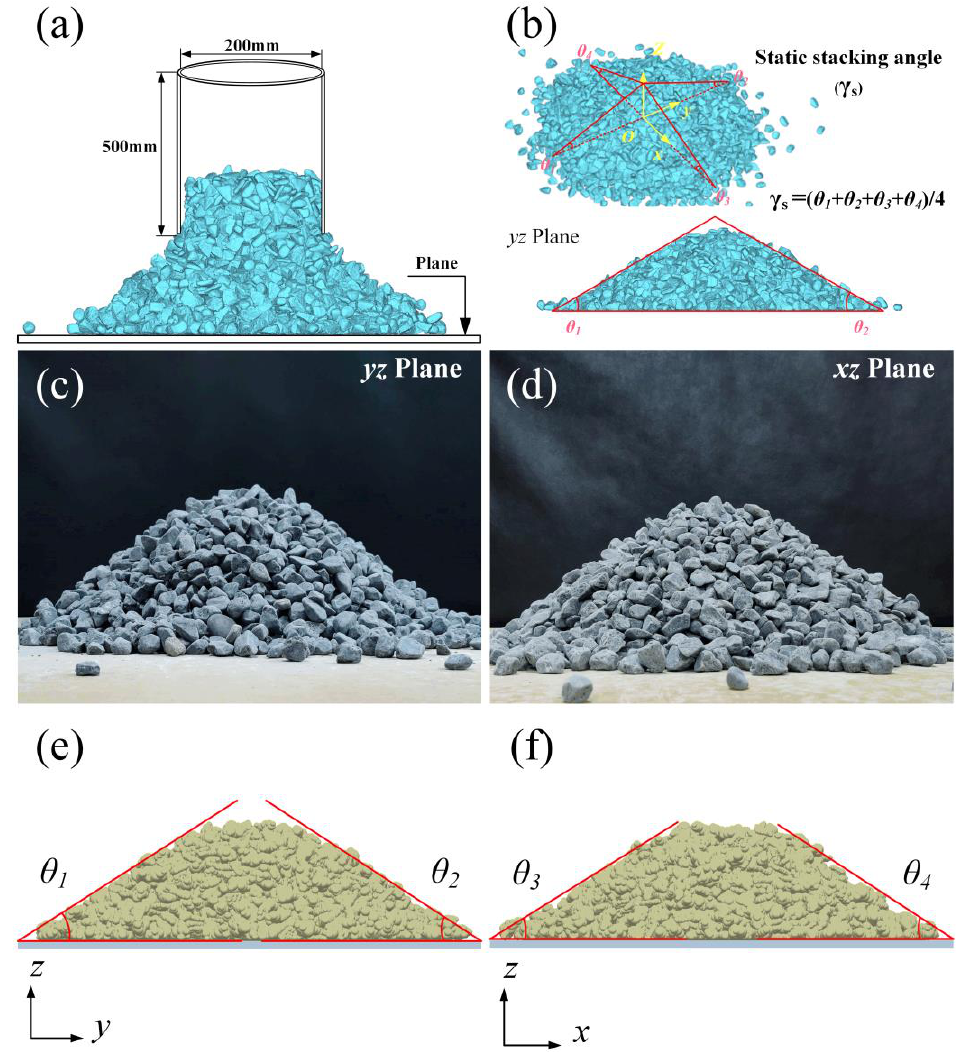
Figure 14. The principle of static stacking angle and comparison of results: ( a , b ) size and measurement settings of test setup; ( c , d ) results of yz and xz plane test; ( e , f ) results of yz and xz plane simulation. Table 10. Comparison of experimental and simulation results of static stacking angle.